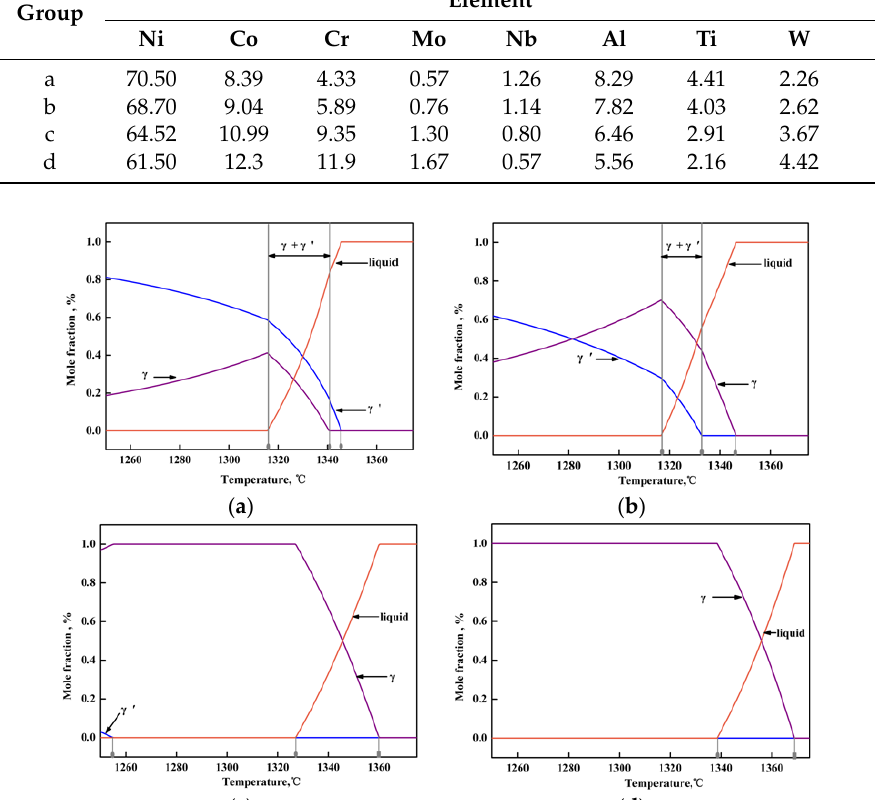
Table 3. Typical chemical constituents for thermodynamic calculation (mass fraction, %). Group